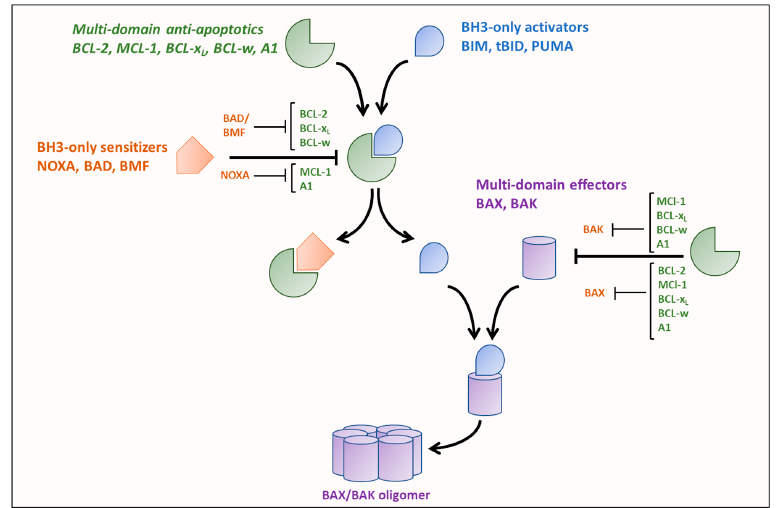
Figure 1. Unified model of BCL-2 protein family interactions. BH3-only activators (BIM, tBID, and PUMA) can bind to the multi-domain anti-apoptotics (BCL-2, MCL-2, BCL-x L , BCL-w, and A1) as